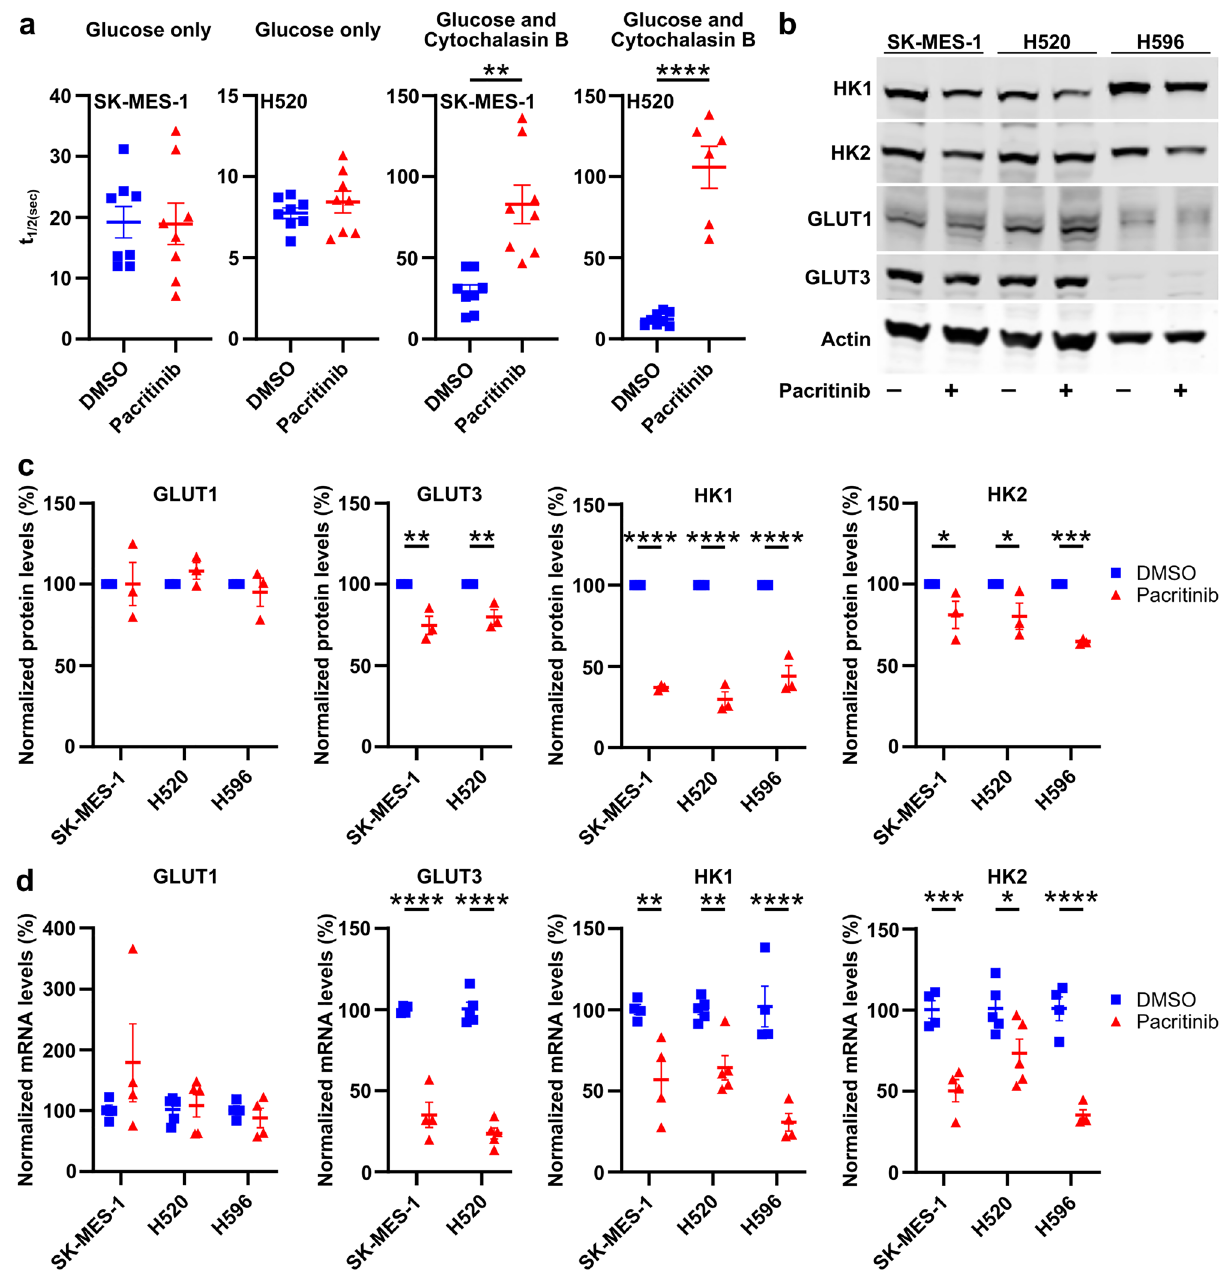
Figure 3. Pacritinib blocks hexokinase expression and activity. ( a ) The rate of change in yellow fluorescence for a FRET-based glucose reporter in SK-MES-1 and H520 cells treated with vehicle or pacritinib and incubated with glucose only or glucose and Cytochalasin B. ( b ) Representative immunoblots and ( c ) quantification of GLUT1, GLUT3, Hexokinase 1 (HK1), and Hexokinase 2 (HK2) protein levels in SK-MES-1, H520, and H596 cells treated with vehicle or pacritinib. Full-length, uncropped blots are presented in Supplementary Figure. 3. ( d ) mRNA levels of GLUT1, GLUT3, HK1, and HK2 in SK-MES-1, H520, and H596 cells treated with vehicle or pacritinib. * P < 0.05; ** P < 0.01; *** P < 0.001; **** P < Mutations in FLT3 are rare in tumor samples from patients with squamous cell lung cancer and most reported mutations are of unknown significance 35 . How FLT3 is activated to drive glucose consumption in our cell lines remains to be determined. However, the fact that we show that pacritinib blocks glucose consumption in squa- mous cell lung cancer in vivo without affecting glucose consumption in healthy tissues suggests that a role for FLT3 in driving glucose consumption is cancer specific. In the absence of activating mutations, FLT3 requires FLT3 ligand to be activated 33,34 . One possibility is that the mutations that are present in our cell lines such as inactivating p53 mutations lead to increased FLT3 ligand expression. That and other possibilities will be tested in future studies.